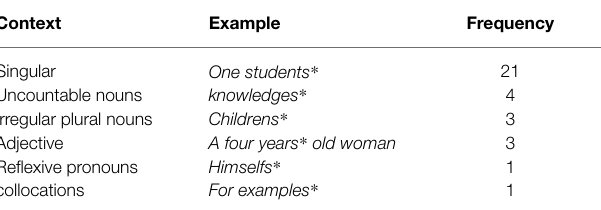
TABLE 3 | Incorrect uses of plural ‘ -s ’ in the spoken